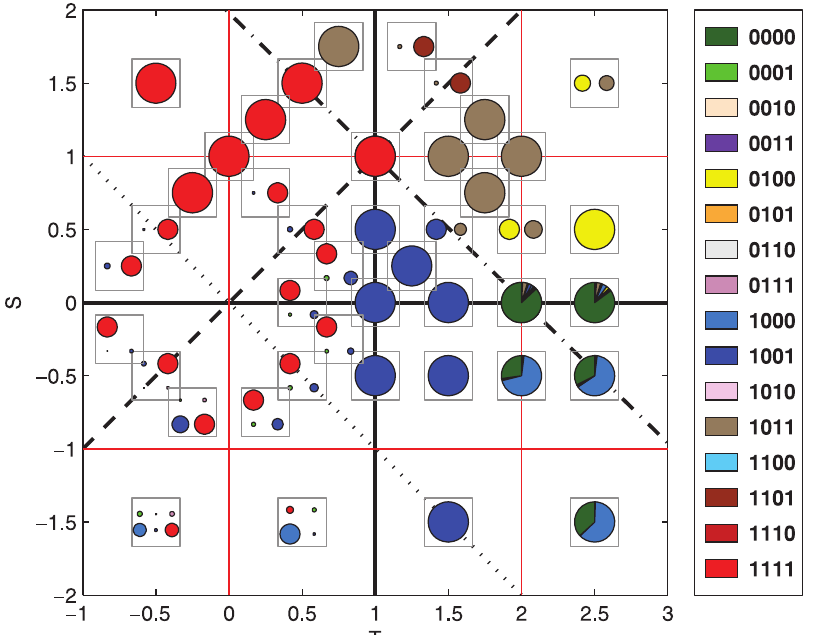
Figure 4. Composition of the recurrent sets for each studied game. The plot is the same as Figure 1, but measuring the transition probabilities as probabilities of absorption.